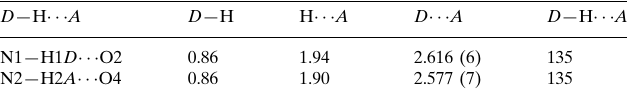
Hydrogen-bond geometry (A ˚ , (cid:2)